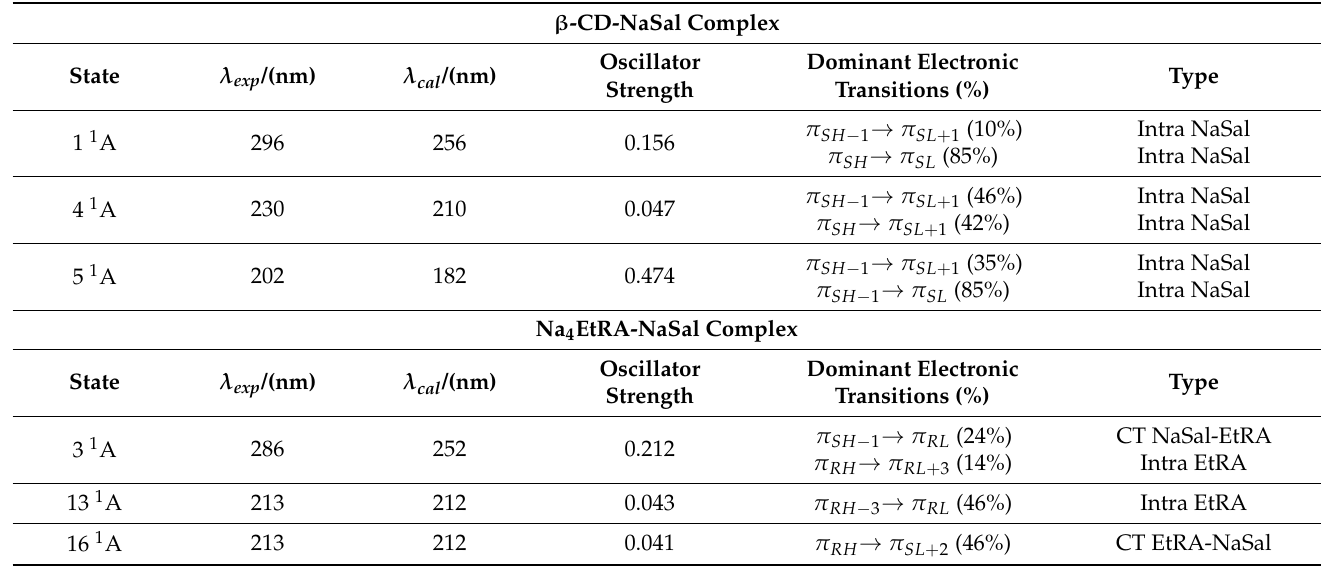
Table 5. Assignment of the bands observed in the absorbance spectra of the host–guest complexes.